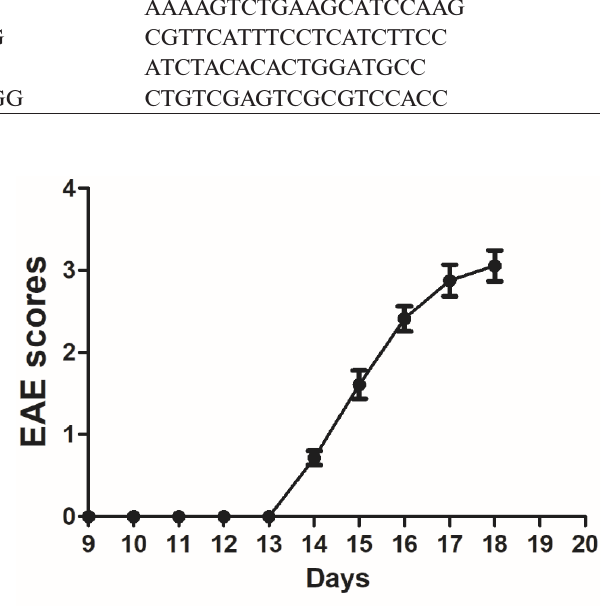
Fig. 2. Development of EAE in the experimental